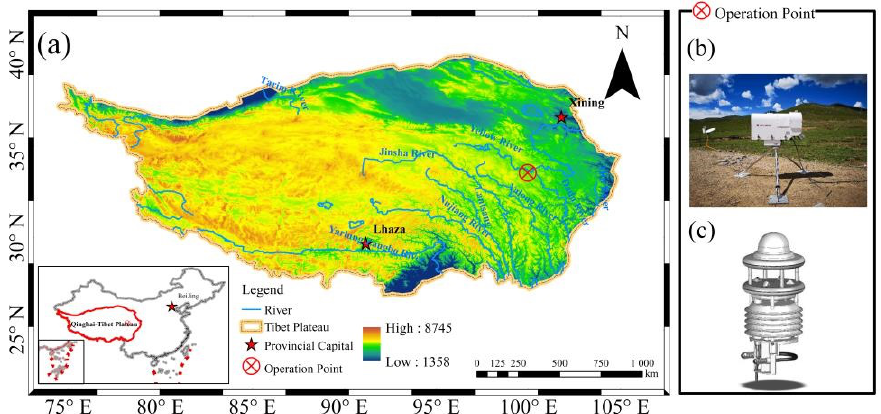
Figure 1. Geographical location of the field site of meteorological observations, ( a – c ) refer to position of field site, MWR and LUFFT weather